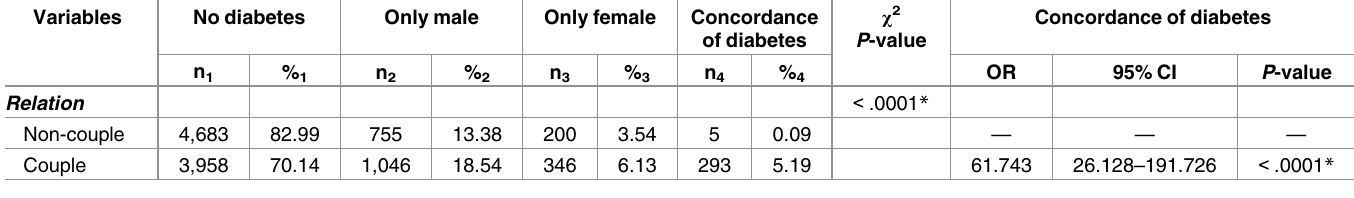
Table 5. Concordance of diabetes in couples and noncouples (dual propensity score matched for sex, age, and comorbidities; chi-squared test and conditional logistic regression; N = 11,286 pairs).